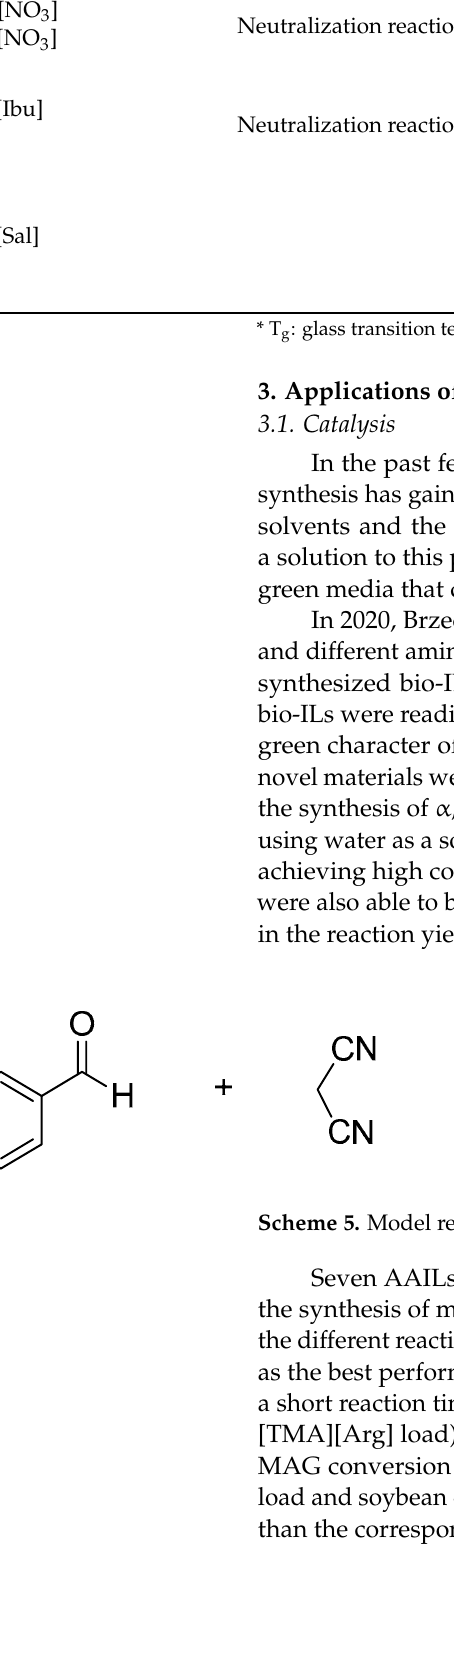
Table 1. Cont. IL Synthesis Physicocemical Properties